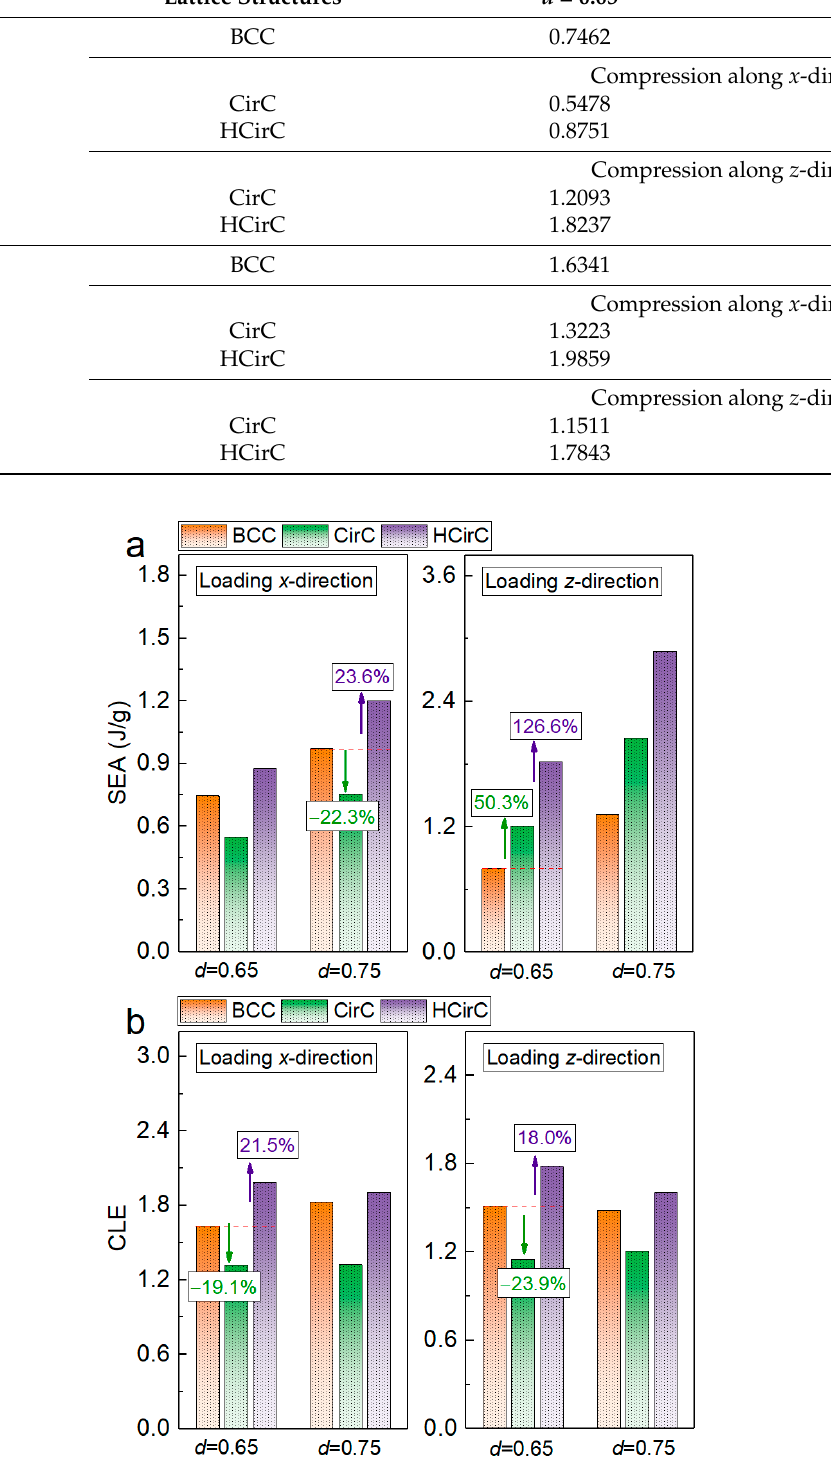
Figure 18. The energy absorption capacity of lattice structures BCC, CirC, and HCirC: in ( a ) for SEA and in ( b ) for CLE.